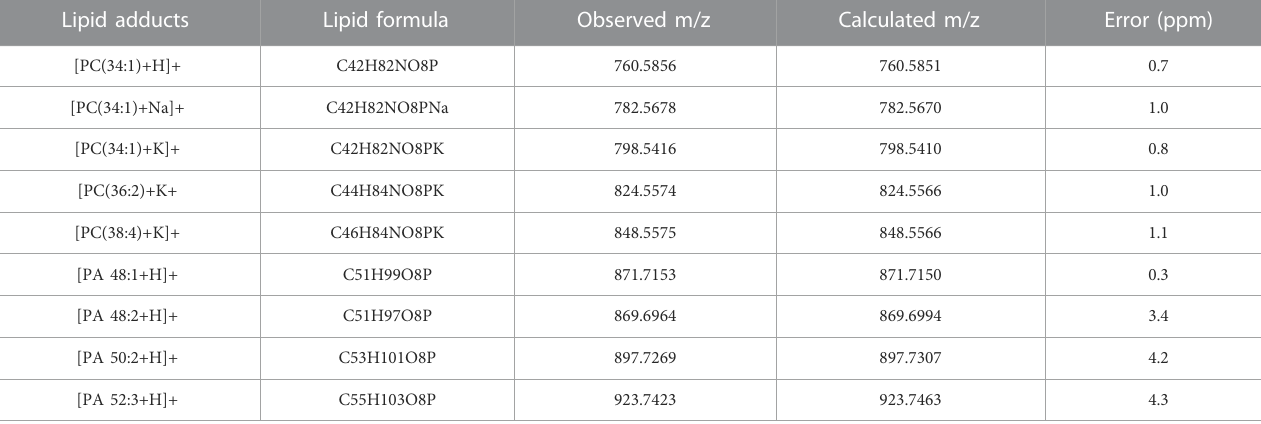
TABLE 1 Typical lipids in thyroid tissue. Error (ppm) = [abs (observed mass – calculated mass)/calculated mass]×10 6 . Lipid adducts Lipid